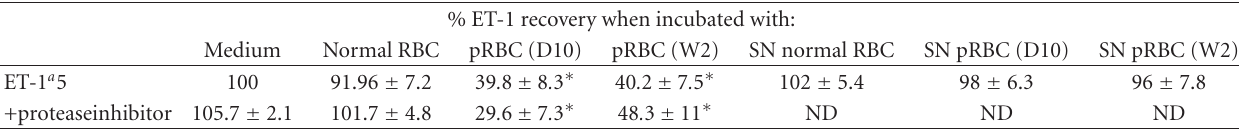
Table 2: E ff ect of normal RBC, pRBC, or supernatants from P. falciparum cultures on the recovery of synthetic ET-1. % ET-1 recovery when incubated